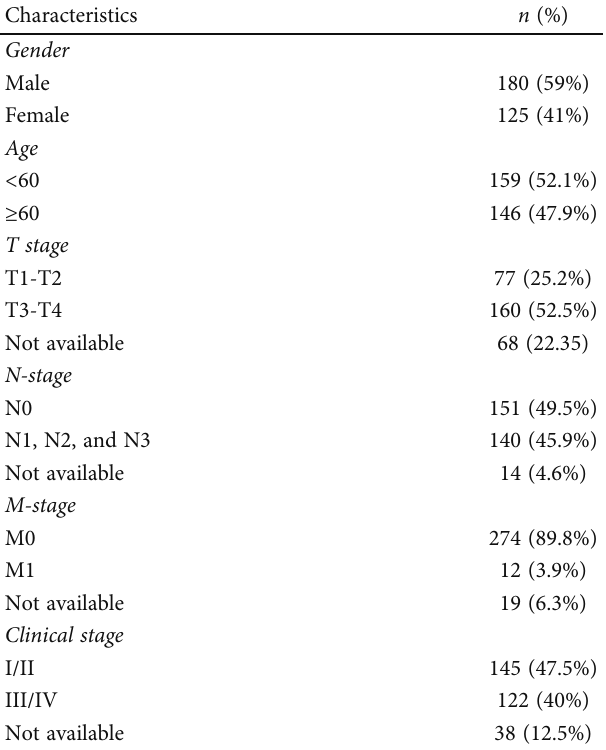
Figure 4: SAMMSON inhibits FOXA2 protein expression in melanoma cells. (a) Volcano plot of di ff erentially expressed genes in patients with high and low SAMMSON expression. Red, green, and black indicate upregulated, downregulated, and una ff ected genes, respectively. (b) Venn diagram for the TFs in DEGs. (c – e) RT-qPCR analysis of the relative mRNA expression of TCF21, FOXA2, and ELF5 in HaCaT and melanoma cell lines. (f) Western blotting analysis of the protein expression of FOXA2 in SAMMSON-silenced and control melanoma cells. (g) RT-qPCR analysis of the relative mRNA expression of EZH2 in SAMMSON-silenced and control melanoma cells. (h) Western blotting analysis of the protein expression of EZH2 and H3K27me3 in SAMMSON-silenced and control melanoma cells. ∗∗ p < 0 : 01 vs. control cells. Table 4: Clinicopathologic parameters in skin cutaneous melanoma patients from the TCGA